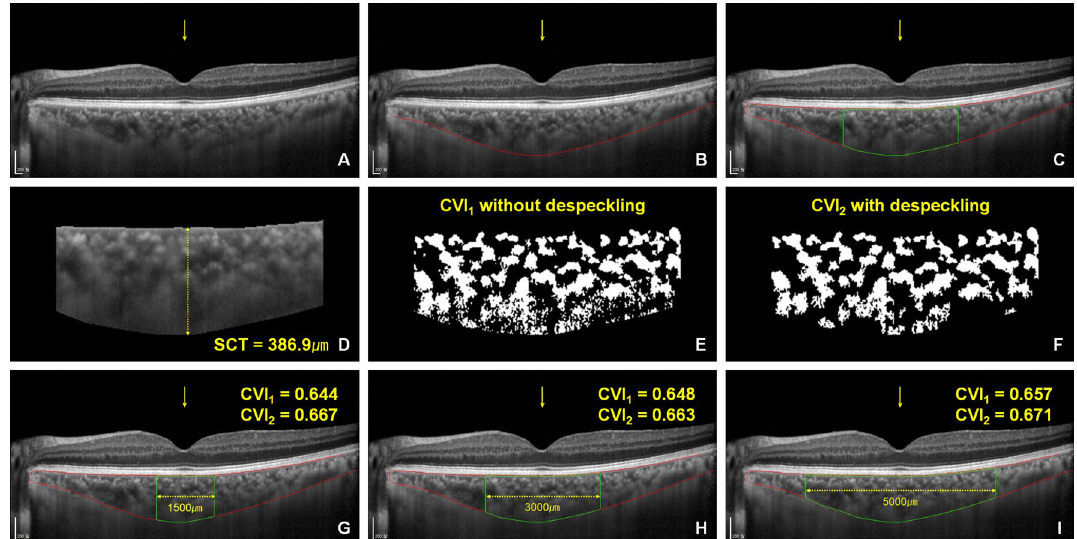
Figure 1. Choroidal vascularity index measurements. ( A ) The center of the fovea is marked with a built-in arrow tool (yellow arrow). ( B ) The outer boundary of the choroid is manually drawn (red line). ( C ) The lower border of the hyperreflective band of RPE/Bruch’s membrane complex (upper red line) and the choroidal area of a predetermined range centered on the fovea are automatically extracted (green border area). ( D ) The subfoveal choroidal thickness (SCT) is automatically calculated. ( E ) Binarized images are obtained using the Niblack thresholding. ( F ) Despeckled image with the removal of particles with less than 20-pixels in size. ( G – I ) The choroidal vascularity index (CVI) is calculated as the ratio of the luminal area (dark area) to the total choroidal area in various choroidal ranges (1500 μm, 3000 μm, and 5000 μm) using both the original (CVI 1 ) and despeckled (CVI 2 ) binarized